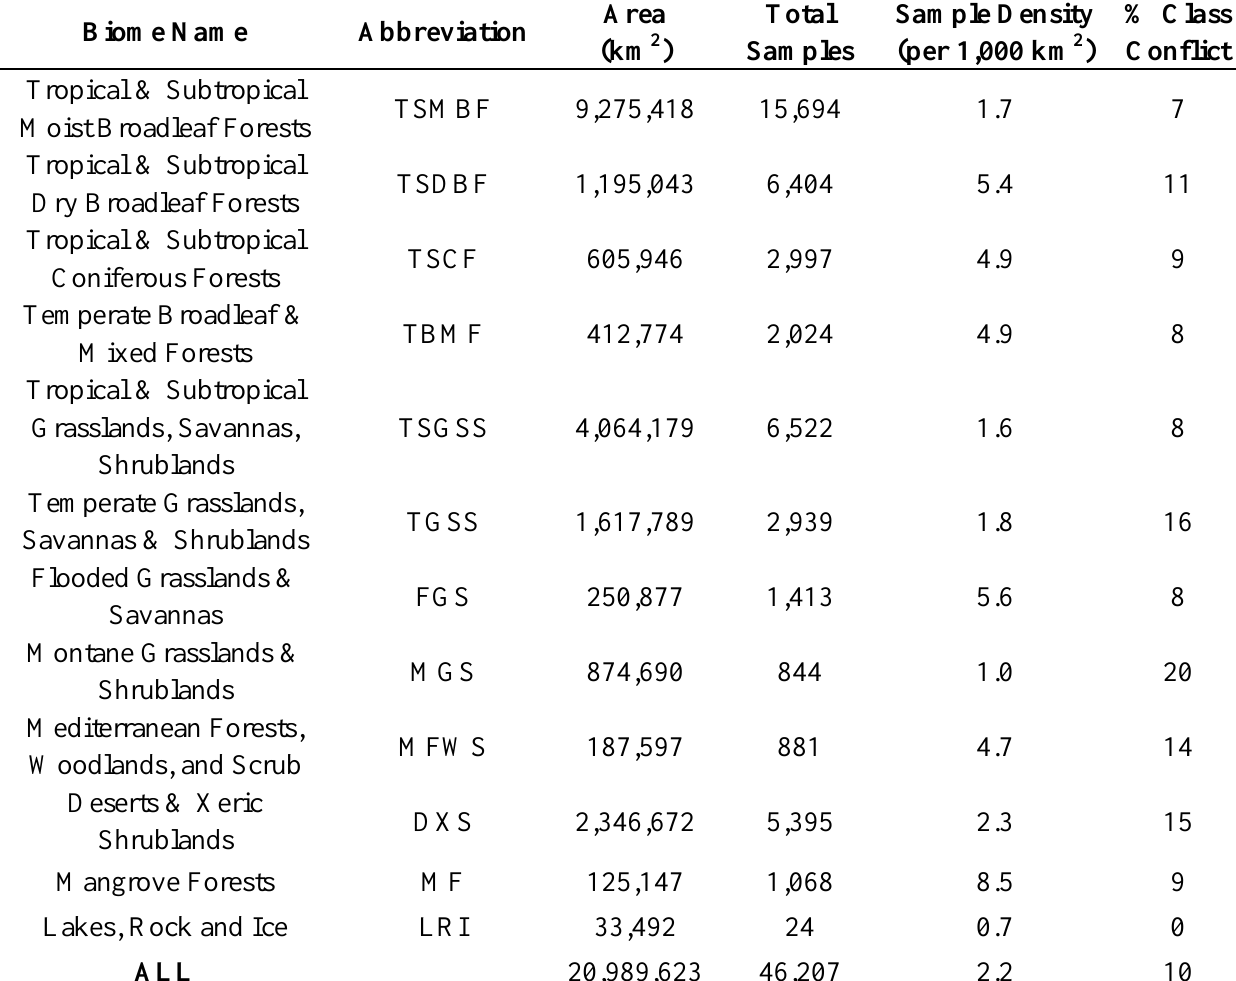
Table 2. VIEW-IT sample count and percent of samples with class conflicts between users for all biomes in Latin America and the